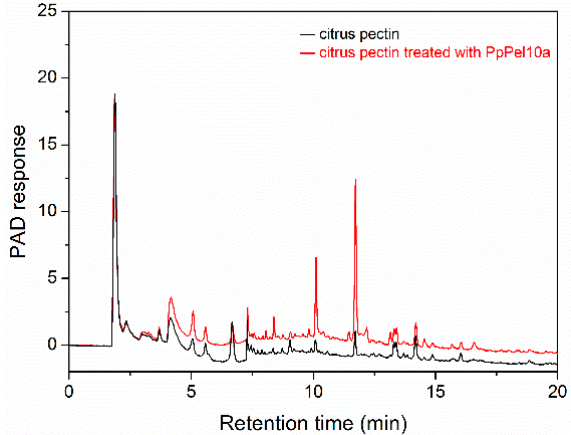
Figure 7. High-performance anion exchange chromatography analysis of the lytic products of citrus pectin produced by PpPel10a. Black line, citrus pectin; red line, lytic products of citrus pectin.